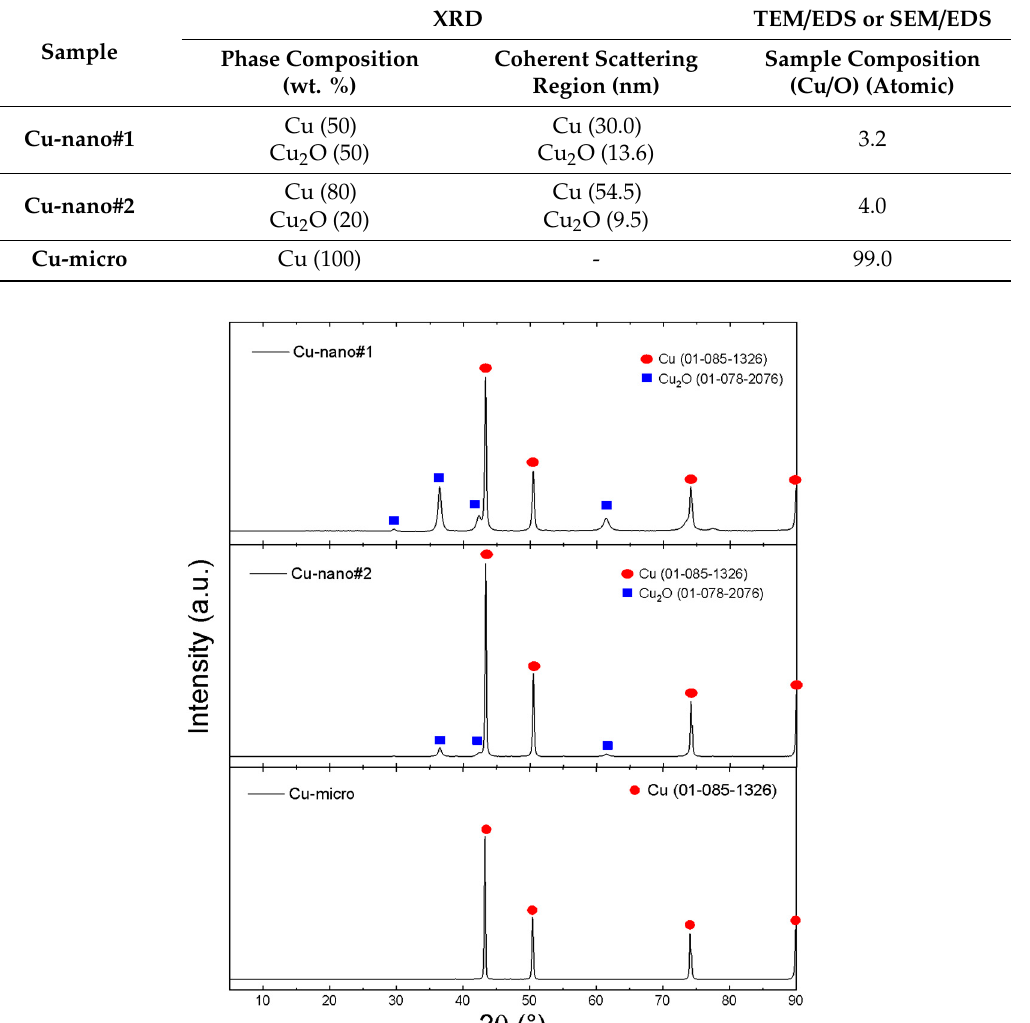
Table 1. Cu samples characterization, transmission electron microscopy (TEM) was used for sample